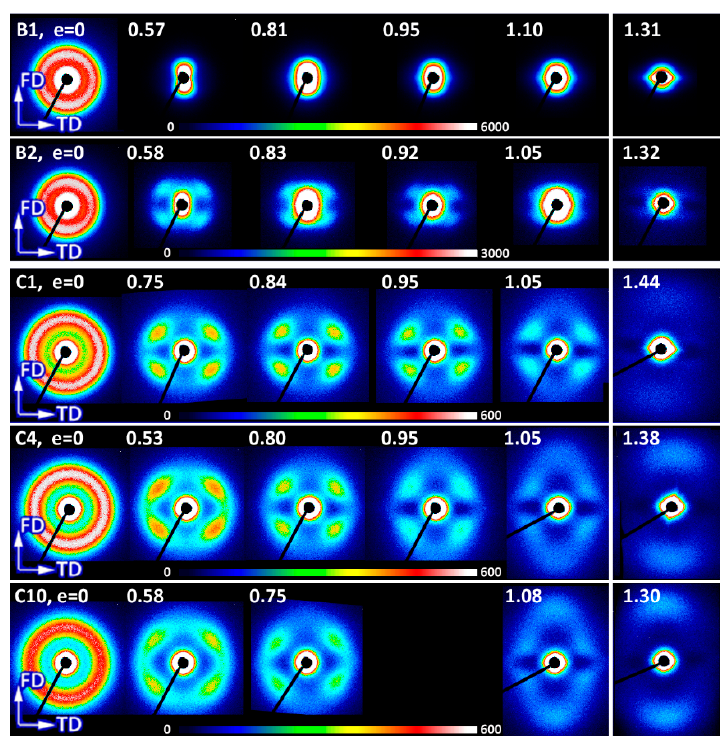
Figure 18. The 2-D SAXS patterns of samples of B1m B2, C1, C4 and C10 deformed to various strain (indicated) in tension. Patterns were obtained in transmission with the primary beam normal to the sample surface. The drawing/flow direction (FD) is vertical.